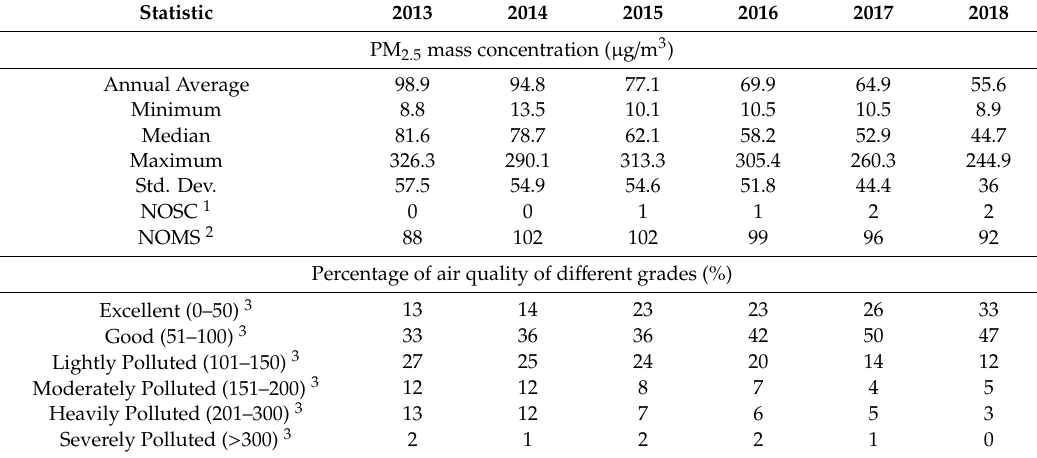
Table 1. Summary of daily particulate matter (PM 2.5 ) mass concentration in the Beijing–Tianjin–Hebei (BTH)